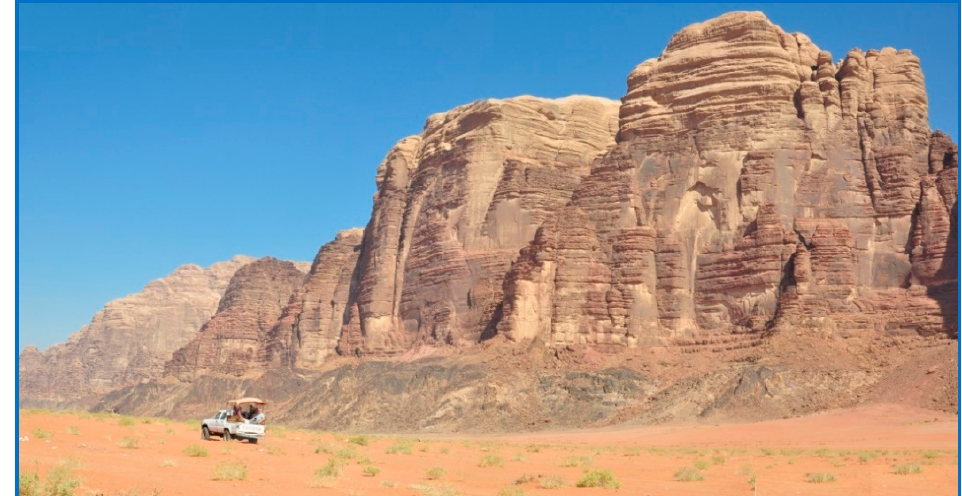
Figure 11. Wadi Rum—a World Heritage Site in Jordan. Photo: Author.